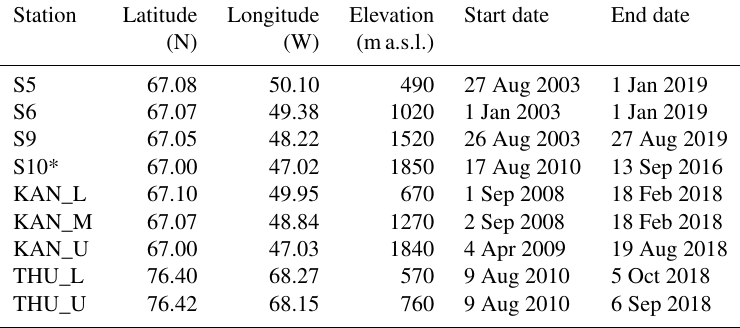
Figure 1. The two GrIS AWS transects used in this study (a) : blue represents ocean, green ice-free tundra, and white glaciated areas and location of AWS sites. The transects are magnified in (b) and (c) . Red squares are IMAU AWSs and green circles PROMICE AWSs. Dashed gray lines are 500m elevation contours. Table 1. AWS location, elevation and start of observations.